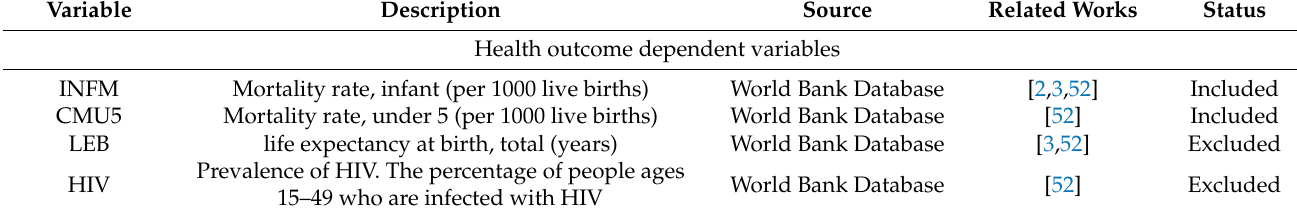
Table A1. Data source according to previous